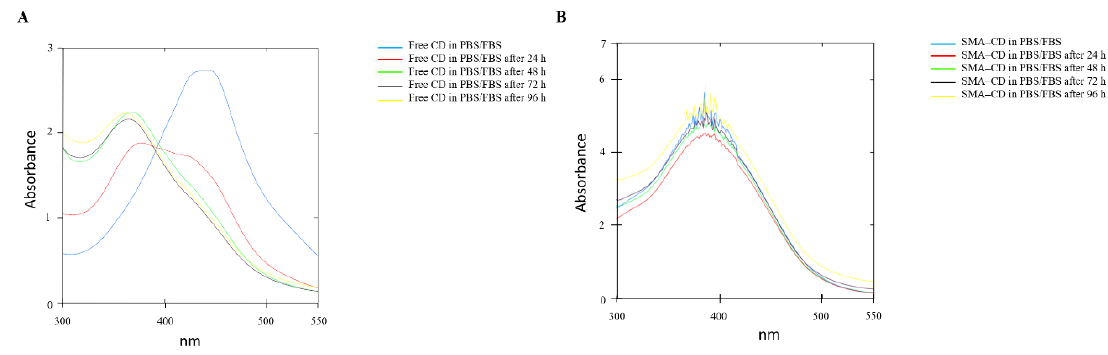
Figure 2. UV/Vis absorption spectra of CD and SMA–CD incubated at 37 °C in phosphate-buffered saline (PBS)/fetal bovine serum (FBS) (4:6) for 96 h. ( A ) Superimposing UV/Vis absorption spectra of CD measured at 0 h, 24 h, 48 h, 72 h, and 96 h; ( B ) Superimposing UV/Vis absorption spectra of SMA–CD measured at 0 h, 24 h, 48 h, 72 h, and 96 h. All experiments were performed in triplicate.